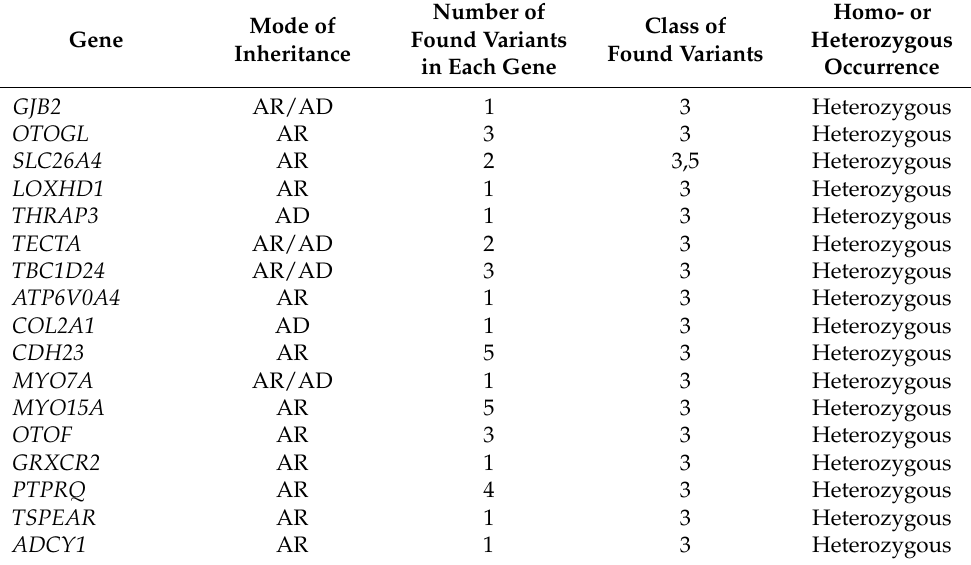
Table 1. Variants found after initial genetic testing (AD = autosomal dominant, AR = autosomal